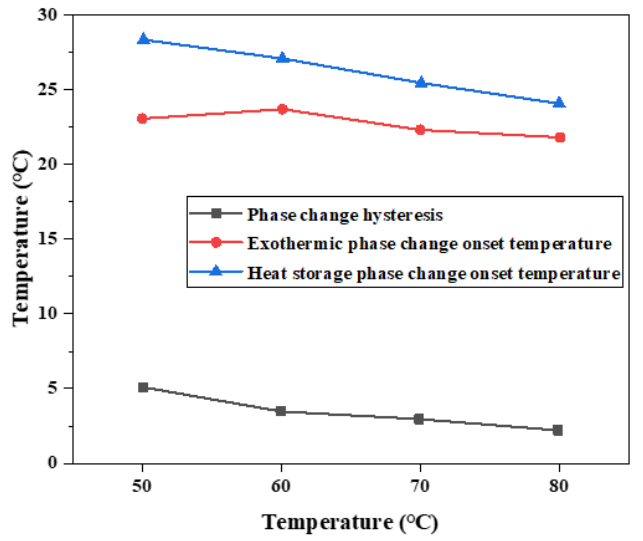
Figure 8. Influence of different heat storage temperatures on hysteresis characteristics of phase transition.